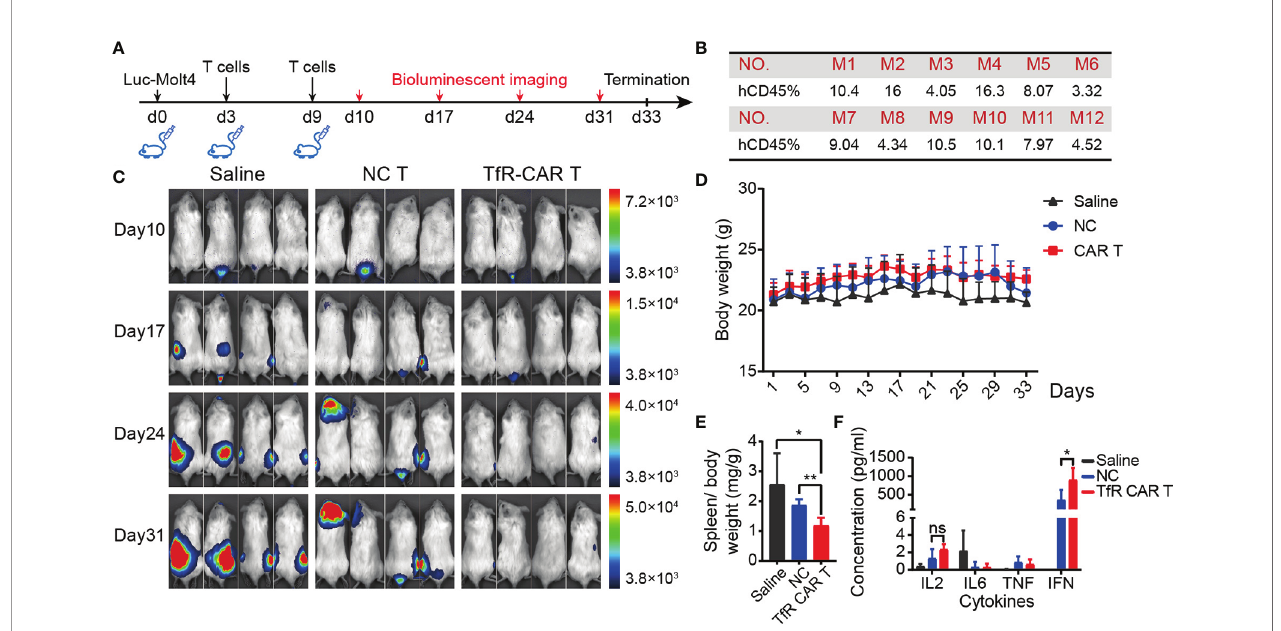
FIGURE 4 | TfR-CAR T cells prevented T-ALL tumor progression in vivo . NPG mice were intravenously inoculated with Luc ‐ Molt4 cells (1 × 10 6 ) on day 0. T cells (4 × 10 6 ) were adoptively transferred on day 3 and day 9. Tumor burden were monitored by bioluminescent imaging on day 10, day 17, day 24, and day 31. If one tumor-bearing mouse exhibited the signs of morbidity, the experiments were terminated. Mice were sacri fi ced for main tissues and blood collection. (A) Schematic diagram for the development of xenograft mouse model. (B) Percentage of huCD45 + cells in the peripheral blood 48 h after engraftment. (C) Mice demonstrated >1% human ALL were randomly assigned to experimental treatment (n = 4 mice per cohort). Tumor progression were detected by in vivo bioluminescence imaging. Representative images of two independent experiments are shown. (D) Body weight and (E) Spleen weight over total body weight were analyzed. (F) Plasma cytokines were determined by CBA. All data are presented as means ± SD. * P < 0.05, ** P < 0.01. ns indicates no statistical